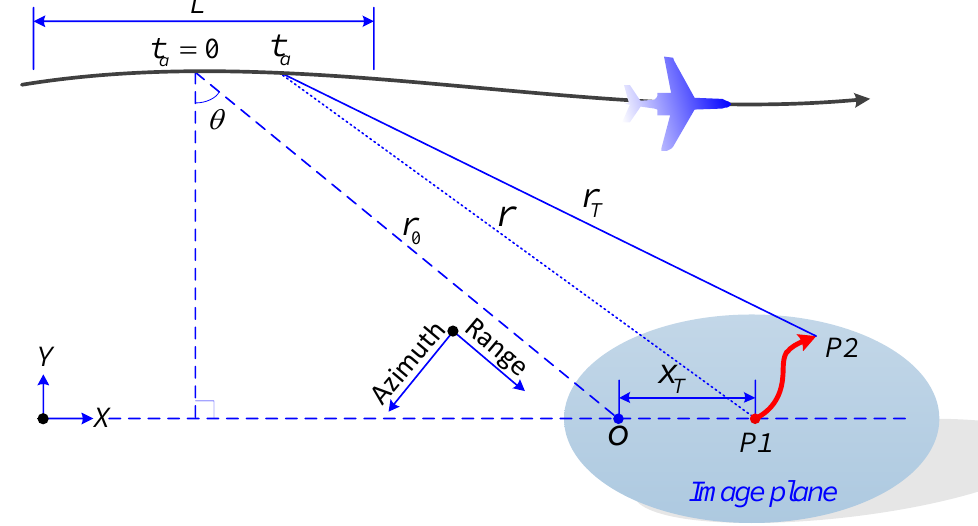
Figure 1. High-squint SAR geometry with a ground maneuvering moving